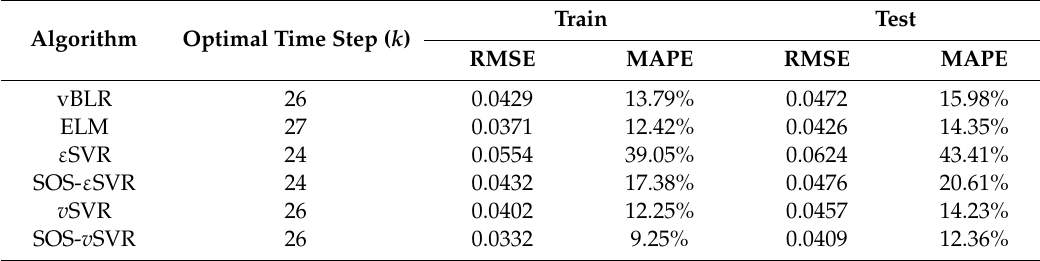
Table 3. Prediction results of SVR, vBLR, and